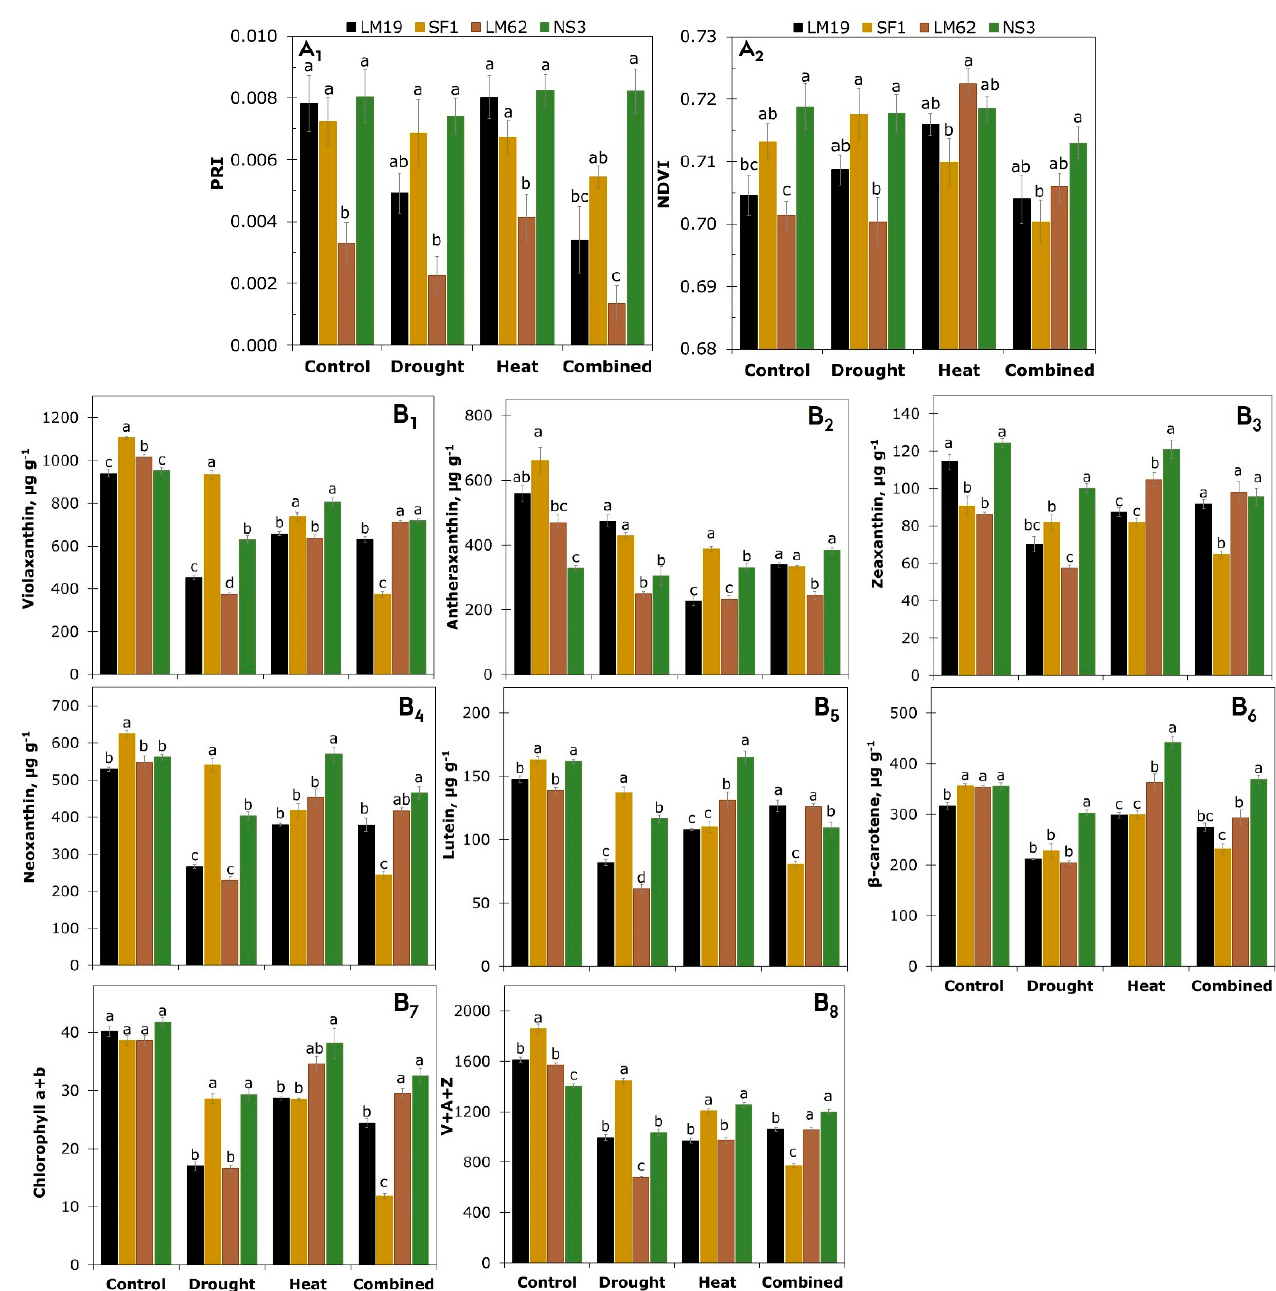
Figure 7. Leaf pigment measurements. ( A 1,2 ) Photochemical reflectance index (PRI) and normalized difference vegetation index (NDVI) determined with Polypen RP410 at the last day of four different treatments in four wheat genotypes. The data represent mean values ± S.E.M. ( n = 9). ( B 1–8 ) Leaf pigment contents at the last day of stress treatments in four wheat genotypes. The data represent mean values ± S.E.M. ( n = 4). Different small letters indicate significant differences in each genotype by using Tukey’s test at level p < 0.05.